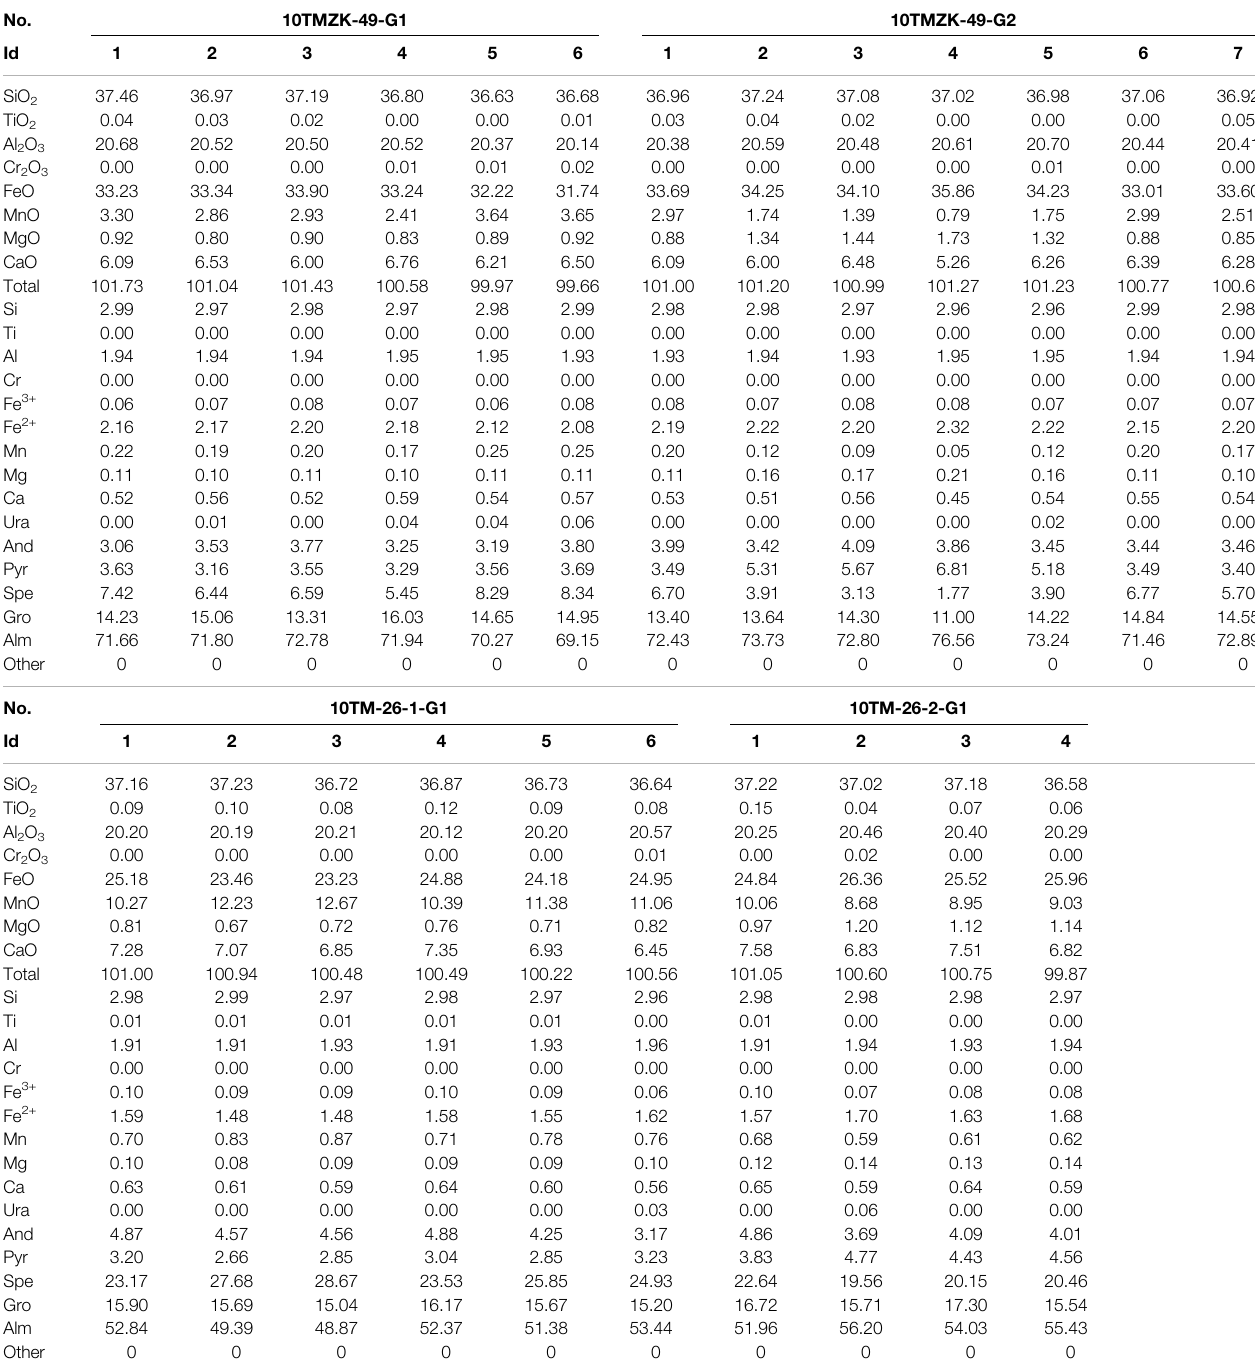
TABLE 2 | EMPA geochemical data (wt%) of the Tiemurt